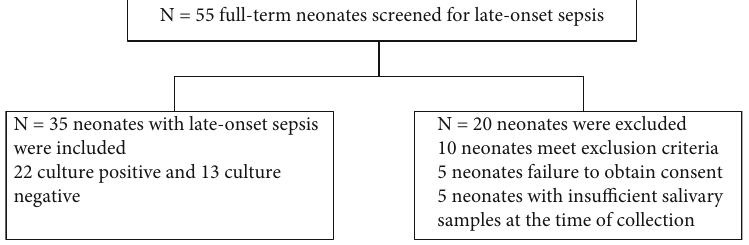
Figure 1: Patient ’ s fl ow chart. Table 1: Comparison of biomarkers for late-onset sepsis between septic and control neonates.